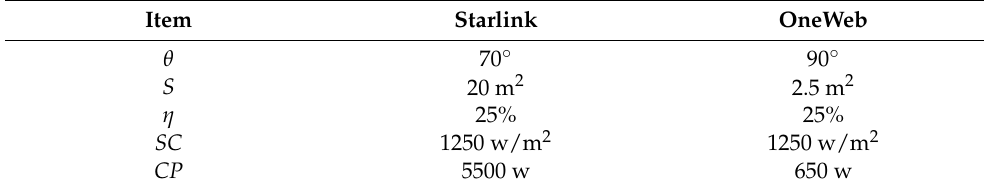
Table 1. Power system parameters.